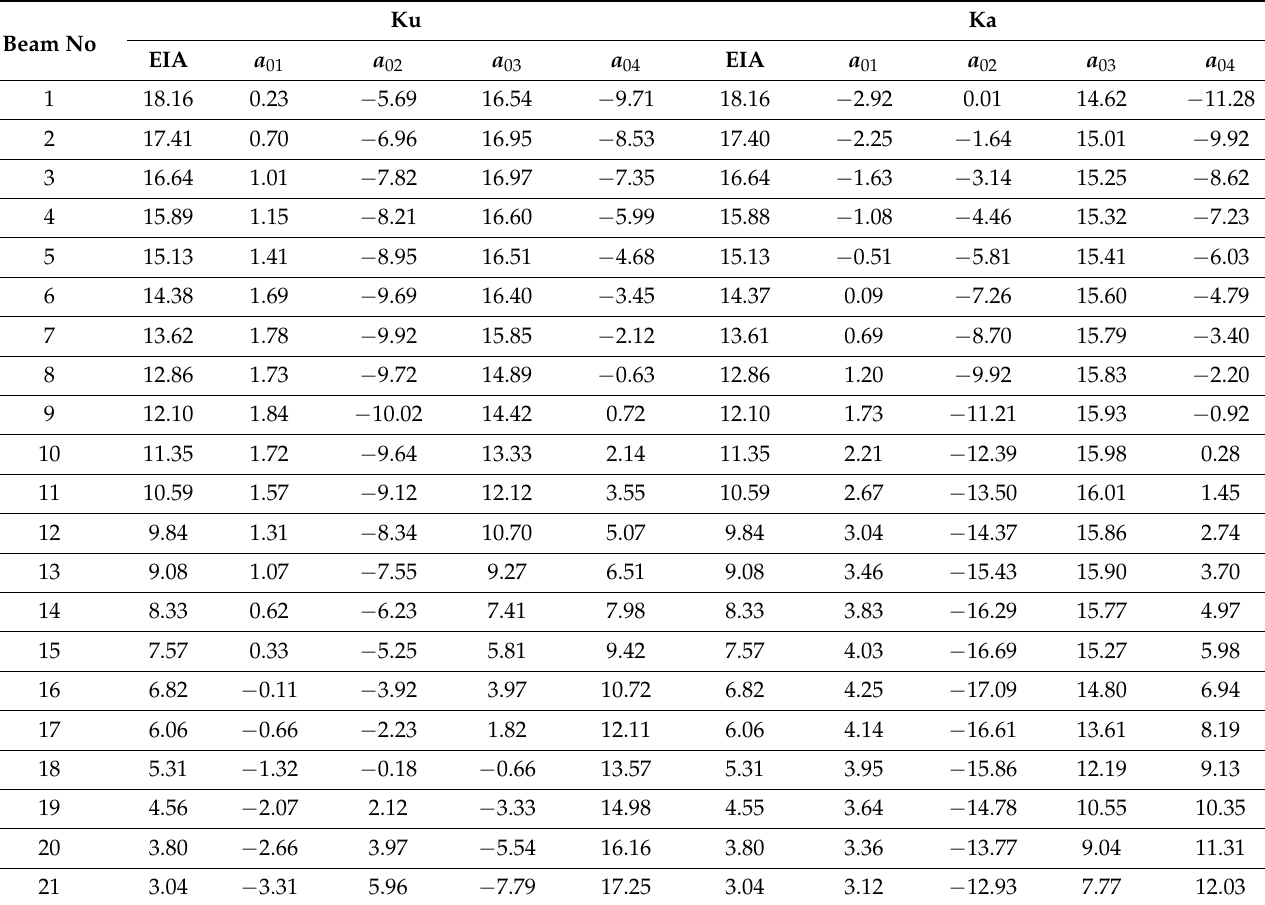
Table A1. Polynomial coefficients for Ku- and Ka-band A 0 model in dB (Equation